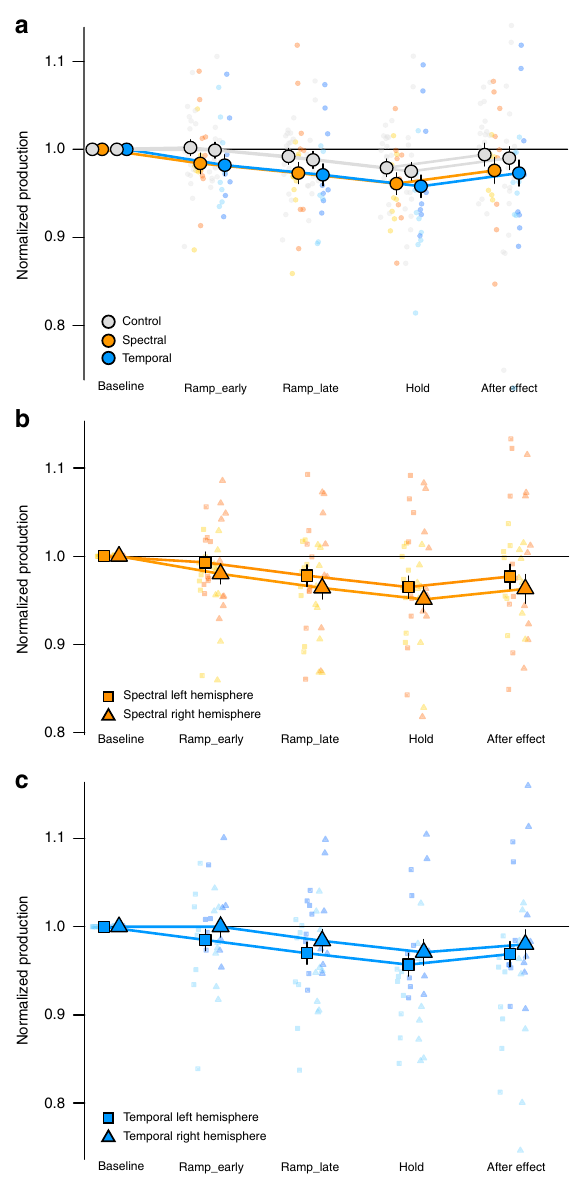
Fig. 1 Compensation in the course of the dichotic listening experiment. Main effect of block for speaking a with unaltered auditory feedback (gray) or speaking with binaurally presented spectral (orange) or temporal (blue) auditory feedback perturbations in blocks of twenty trials. Main effect of block for speaking with dichotically presented spectral ( b , orange) and temporal ( c , blue) feedback perturbations (squares correspond to left hemisphere responses, triangles correspond to right hemisphere responses). In dichotic conditions, one ear perceived the spectrally or temporally altered feedback, while the other ear perceived the unaltered, normal feedback. Produced speech features are relative to baseline, smaller values indicate greater compensation. Data present estimated means ± model derived standard errors that account for between-subject variability ( n spectral = 18 participants, n temporal = 18 participants). Individual raw values are plotted in the background. Their colors denote participants ’ group allocation (yellow: spectral perturbation n = 9 vowel, orange: spectral perturbation consonant n = 9, light blue: temporal perturbation vowel n = 9, dark blue: temporal perturbation fricative n = 9). Source data are provided as a Source Data fi